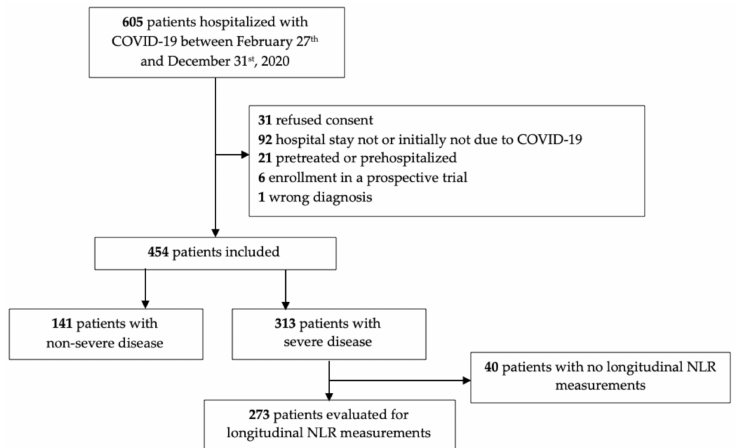
Figure 1. Cohort included in the study.